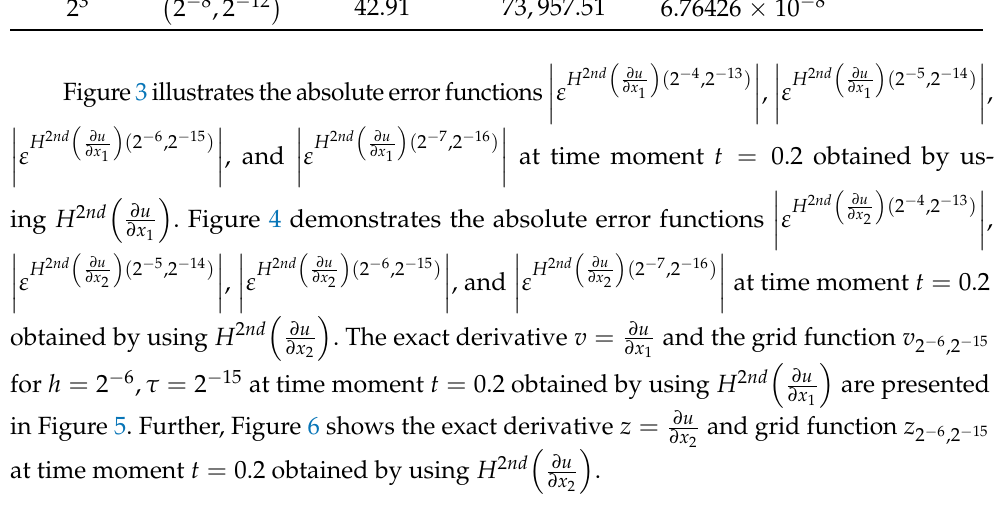
> 3 when r = 0.5 τ 7 ∂ x 2 h 2